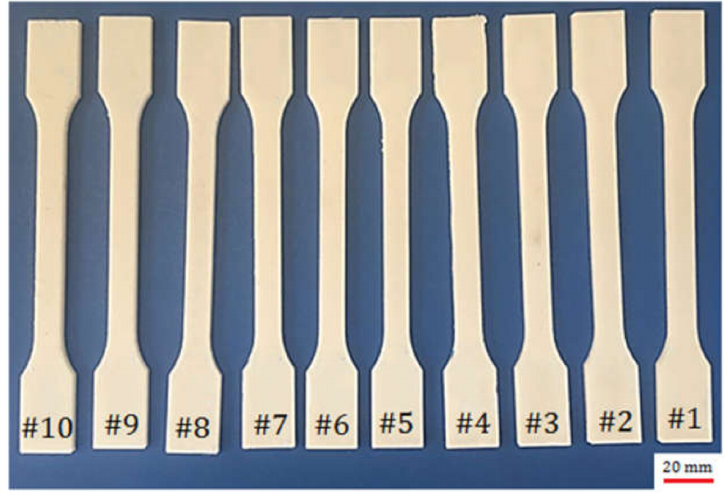
Figure 5. Fused filament fabrication (FFF) 3D printed parts of polylactic acid (PLA). The SANTAM 150 universal test (SANTAM company, Tehran, Iran) was used to conduct tensile strength tests according to ASTM D638 at the constant rate of 2 mm/min. As Table 2 indicates, the specimens had two types of fracture under in-plane loading. Most of the specimens demonstrated brittle behavior with no visible deformation before fracture. Only five specimens showed a tough fracture and apparent deformation occurred before separation. These specimens had both a higher strength and ductility than that of the brittle